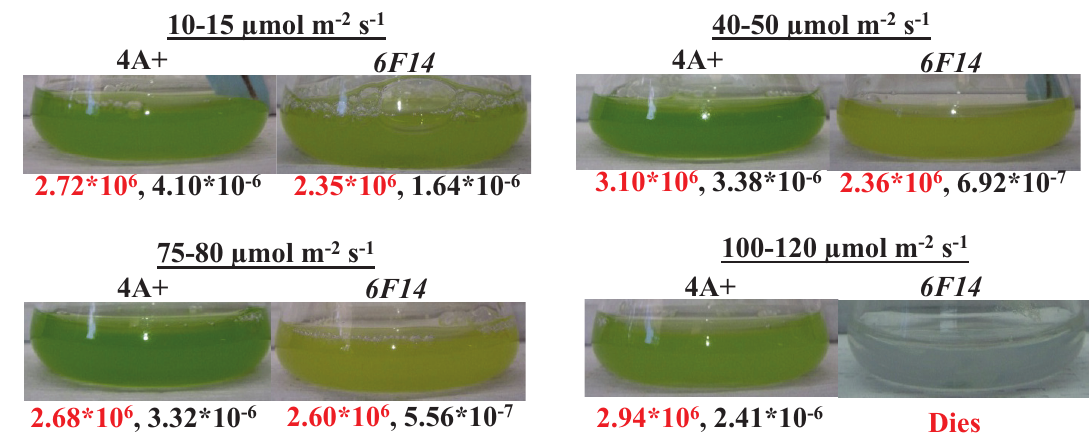
Figure 5. Photo-autotrophic growth of 6F14 and wild-type in HS media. Dark adapted cells of 6F14 and 4A+ were shifted to different light intensities in this experiment. The mean cell density (cells/ml) and the Chlorophyll (Chl) content (nmol Chl per cell) are shown below the culture flasks in red and black numbers, respectively. For each light condition, experiments were performed on three biological replicates of each strain. Statistical error (±SD) was ≤